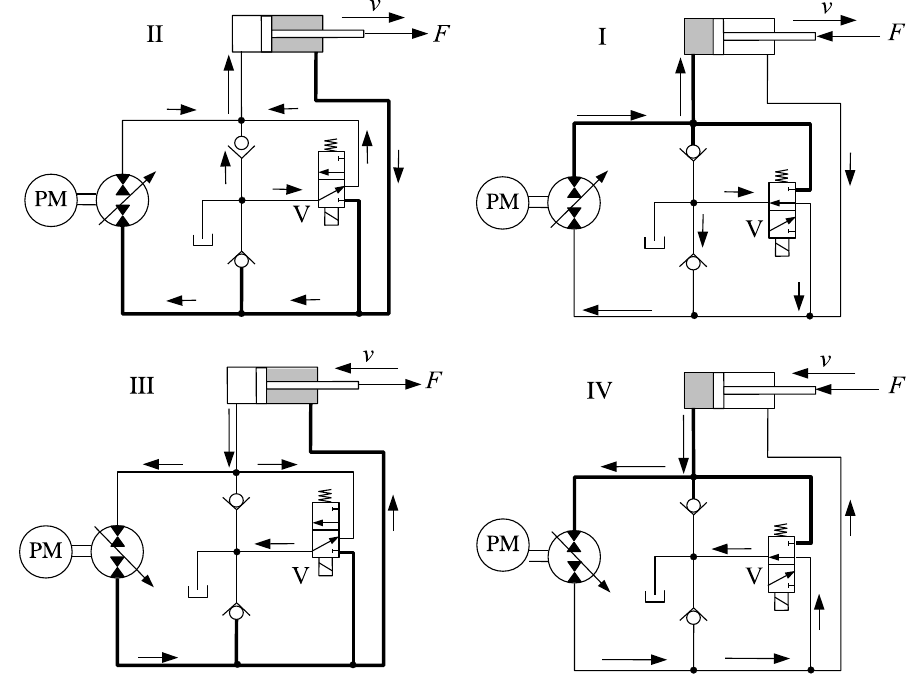
Figure 5. Four-quadrant operation of Hewett’s circuit.